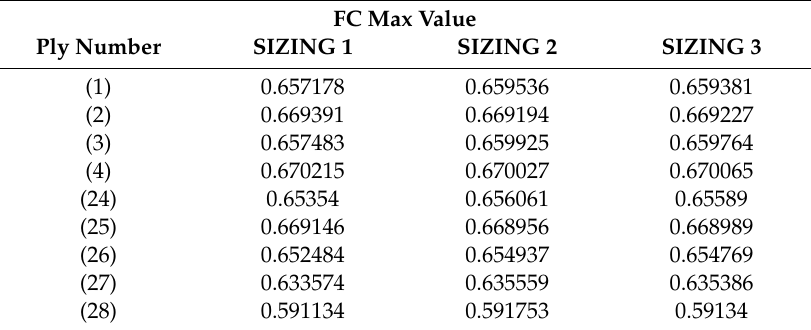
Table 5. Mesh convergence analysis (Model B)